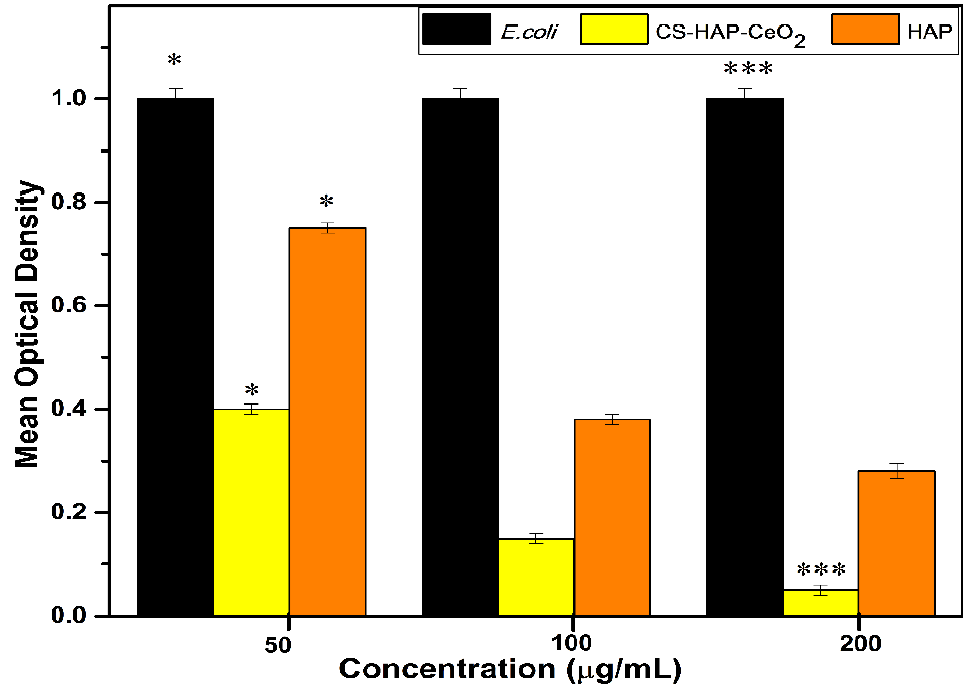
Figure 12. Bar illustrations demonstrating E. coli supplemented with different amounts of HAP and CS-HAP-CeO 2 heterostructure (peak enlargement indicates E. coli deprived of HAP and CS-HAP-CeO 2 ). Considerable difference (* p ≤ 0.05) was perceived between control and treatments. Substantial variance in bacteriostatic effect with HAP and CS-HAP-CeO 2 at high quantity was envisaged. * p ≤ 0.05, *** p ≤ 0.001 suggestively different from virgin culture.